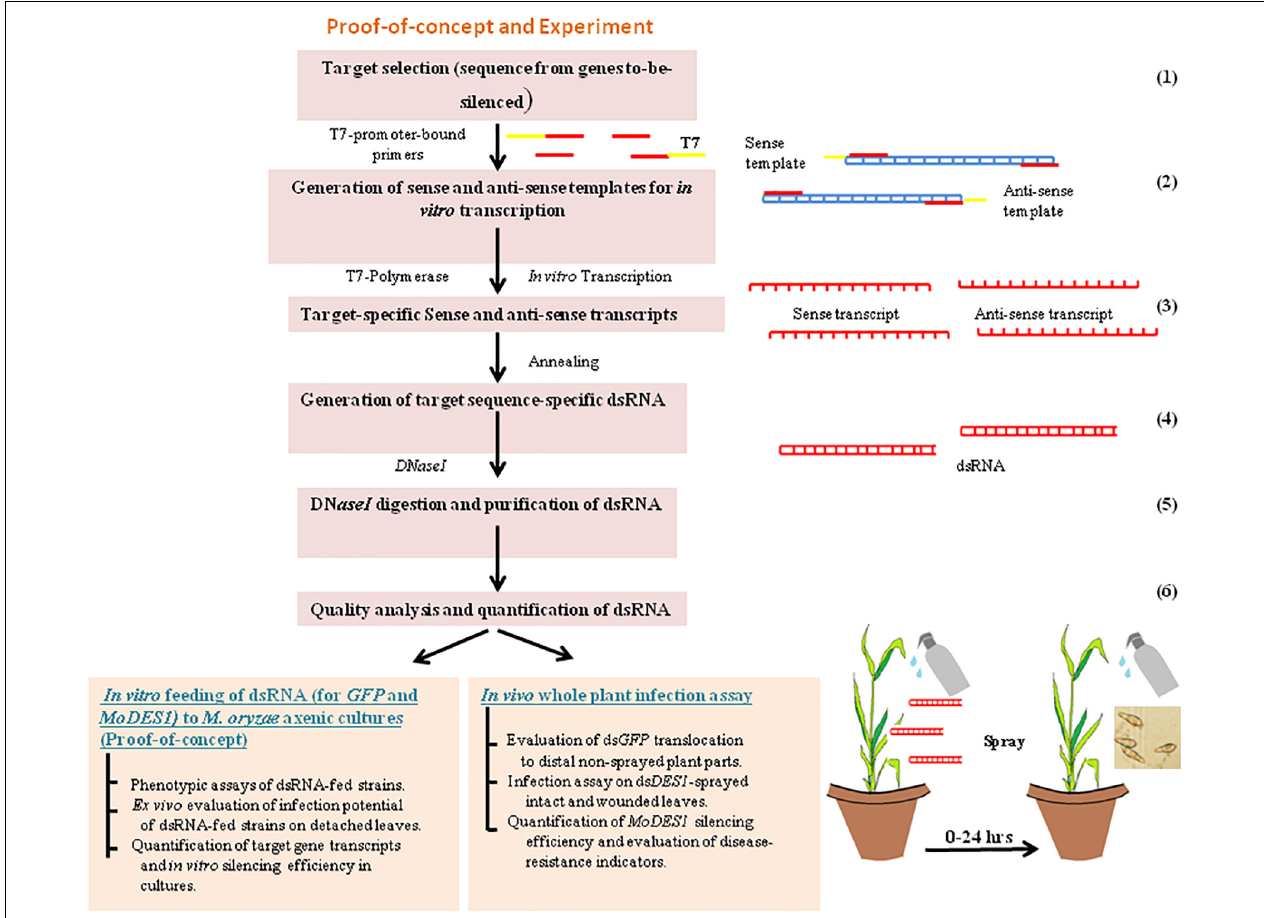
FIGURE 1 | Schematic flow of work. Schematic flow diagram for in vitro synthesis of dsRNA, and proof-of-concept representing its in vitro feeding into Magnaporthe oryzae axenic cultures, in vivo spray-application on rice plant, and infection assay. Numbers on the right hand side indicate the steps involved in the